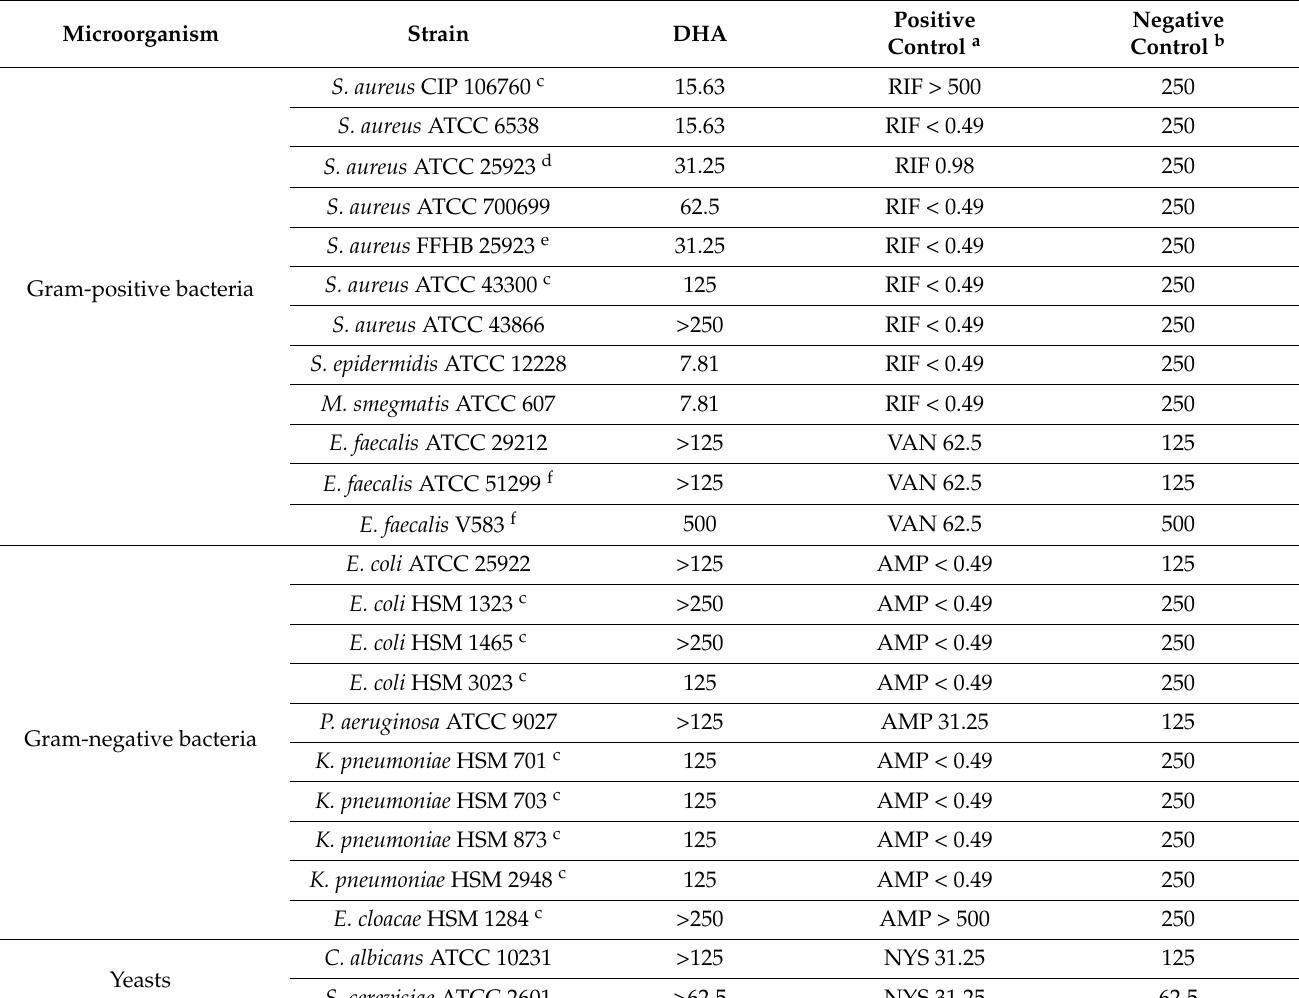
Table 1. Minimum inhibitory concentration (MIC) values ( µ g/mL) of DHA against a collection of Gram-positive and Gram-negative bacteria, and some yeasts. Results showed as mean ± SD, p < 0.05. Microorganism Strain DHA